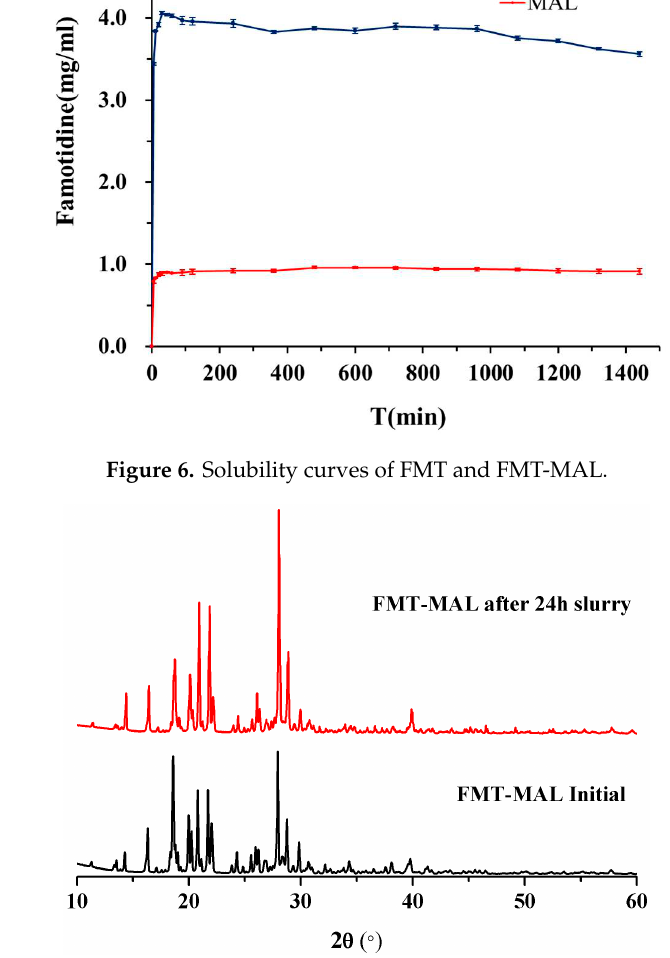
Figure 7. PXRD patterns of FMT-MAL and product after 24 h in a slurry of water.